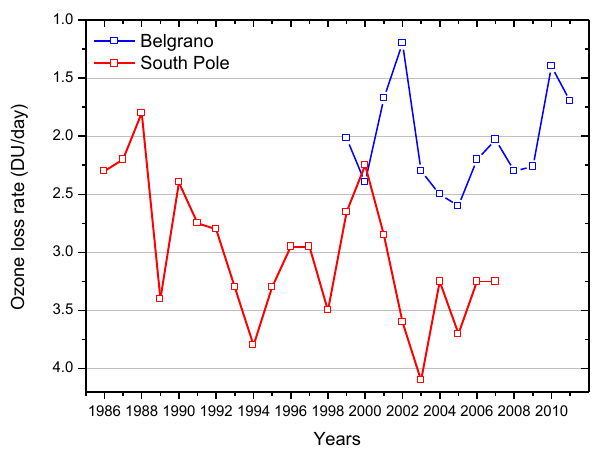
Fig. 8. Time series of ozone loss rate at Belgrano (blue line) and at South Pole (red line) 4 stations. 5